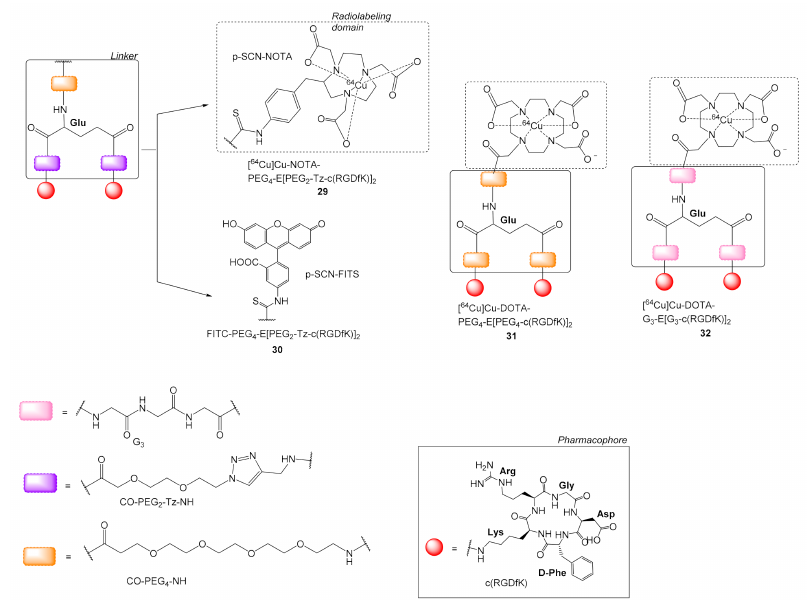
Figure 9. Chemical structures of 64 Cu and FITC labeled c(RGD) peptides with the Tz-PEG 2 spacers 29 and 30, respectively (Tz = triazole group, FITC = Fluorescein isothiocyanate isomer I) and with PEG 4 31 and G 3 32 .